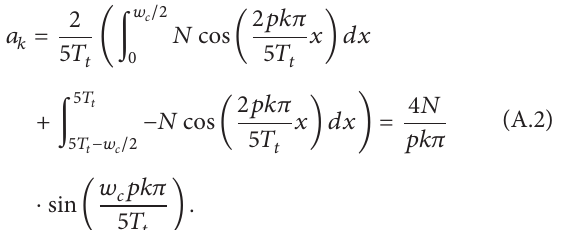
of the detent force is the end-effect force. This is as had